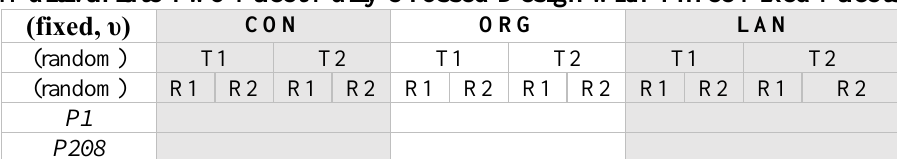
Multivariate Two-Facet Fully Crossed Design with Three Fixed Facets (fixed,